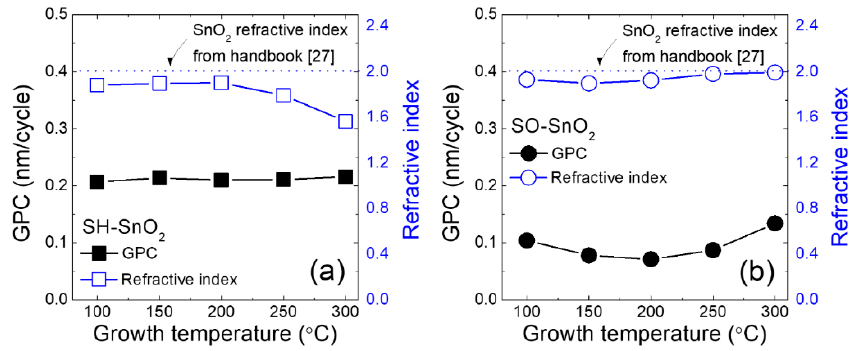
Figure 2. GPC and refractive index of the SnO 2 thin films deposited at 100–300 °C using ( a ) Sn(dmamp) 2 / H 2 O plasma and ( b ) Sn(dmamp) 2 / O 2 plasma.